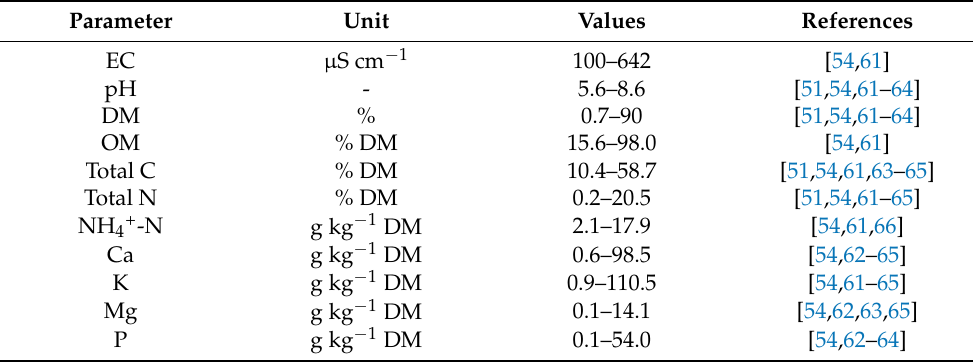
Table 3. Main DG characteristics obtained after AD of different